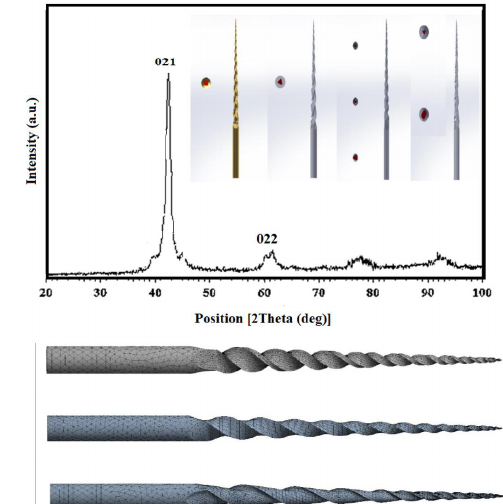
Fig. 1. XRD pattern and design of files including Vortex Blue (32564elements), Edge File (15610elements), Hyflex EDM (19046elements), and One Curve (22488elements) and modeling of